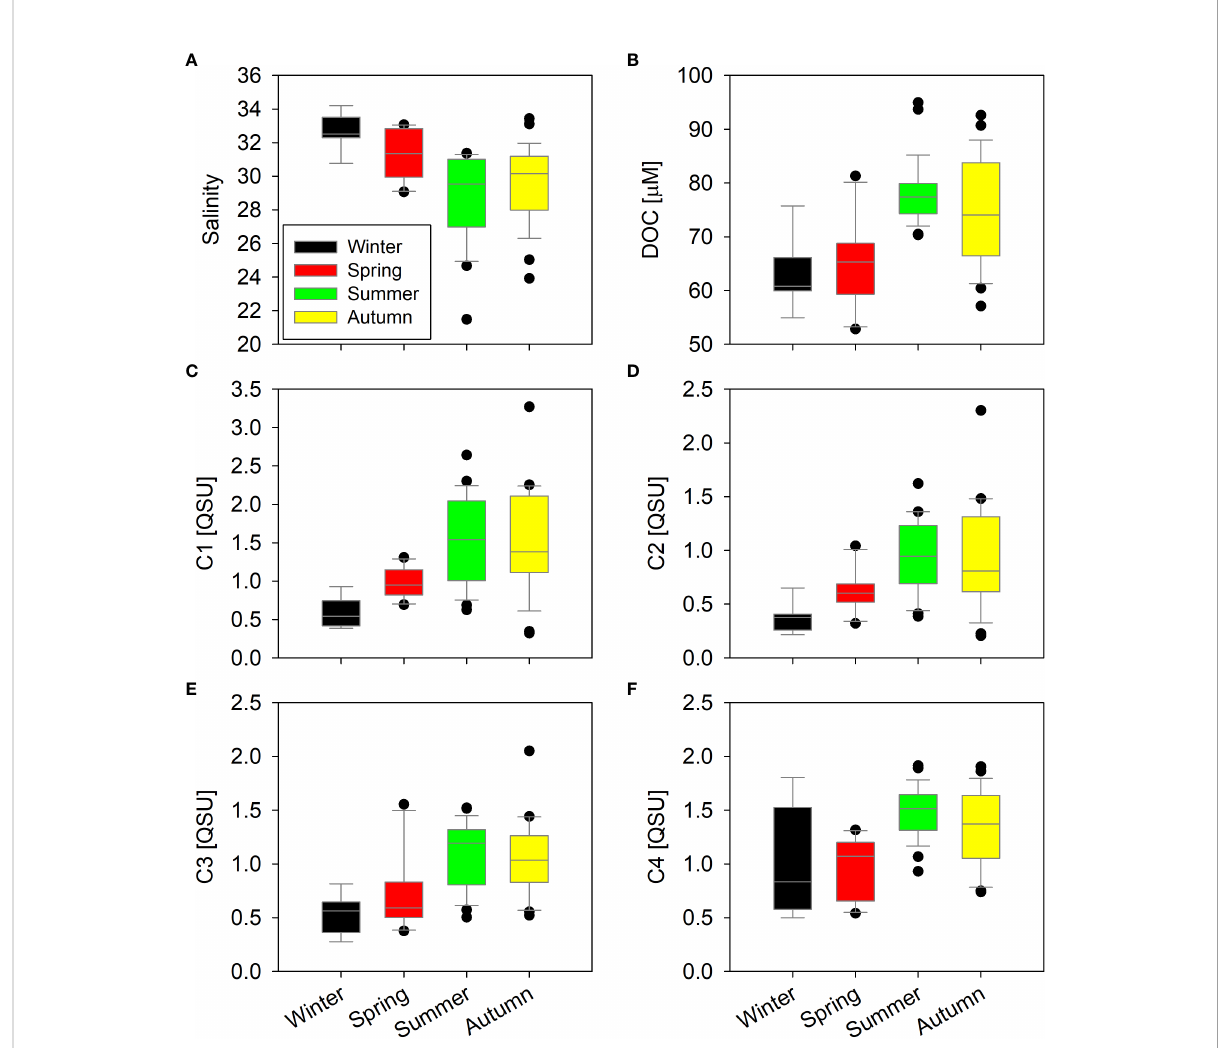
FIGURE 2 Comparison of salinity (A) , DOC (B) , and FDOM components (C – F) in the coastal seawater during different